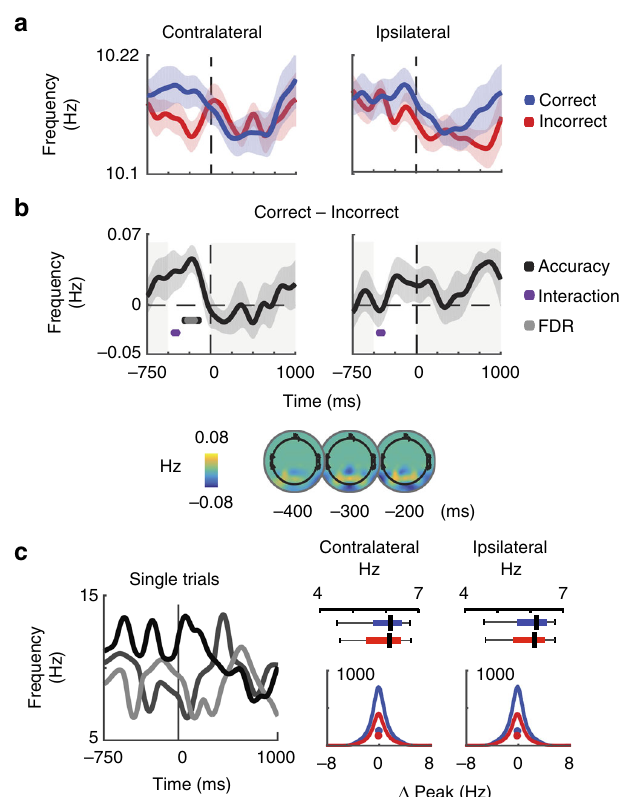
Fig. 4 Topographically selective increases in pre-stimulus frequency predict accuracy. a Contralateral and Ipsilateral electrodes show distinct target- locked patterns in instantaneous frequency. Blue indicates correct trials, red indicates incorrect trials, shaded areas indicate ± 1 SEM within subject. b A pre-stimulus elevation in frequency on correct as compared to incorrect trials is localized to Contralateral electrodes. All dots indicate signi fi cance from zero, evaluated by comparing the obtained t-value with a null distribution of t -values computed by shuf fl ing the condition labels 10,000 times. This analysis was done on a timepoint-by-timepoint basis from − 500ms to stimulus onset, as indicated by the non-shaded areas (see Methods). Signi fi cant main effects are indicated in black, whereas gray dots indicate signi fi cance after FDR correction at P = 0.05. For illustration, Correct — Incorrect topographies reveal elevated pre-stimulus alpha frequency in 100ms bins centered around − 400, − 300 and − 200 ms before the stimulus. c Three example trials of instantaneous frequency highlight single trial dynamics. Boxplots on the upper right indicate the average single trial dynamic range (max — min) of instantaneous frequency on correct (blue) and incorrect (red) trials. Histograms in the lower right show distributions of instantaneous frequency as a function of the distance from peak alpha over all subjects, timepoints, and electrodes in each of the four conditions. Dots in histograms indicate the median shift for that condition